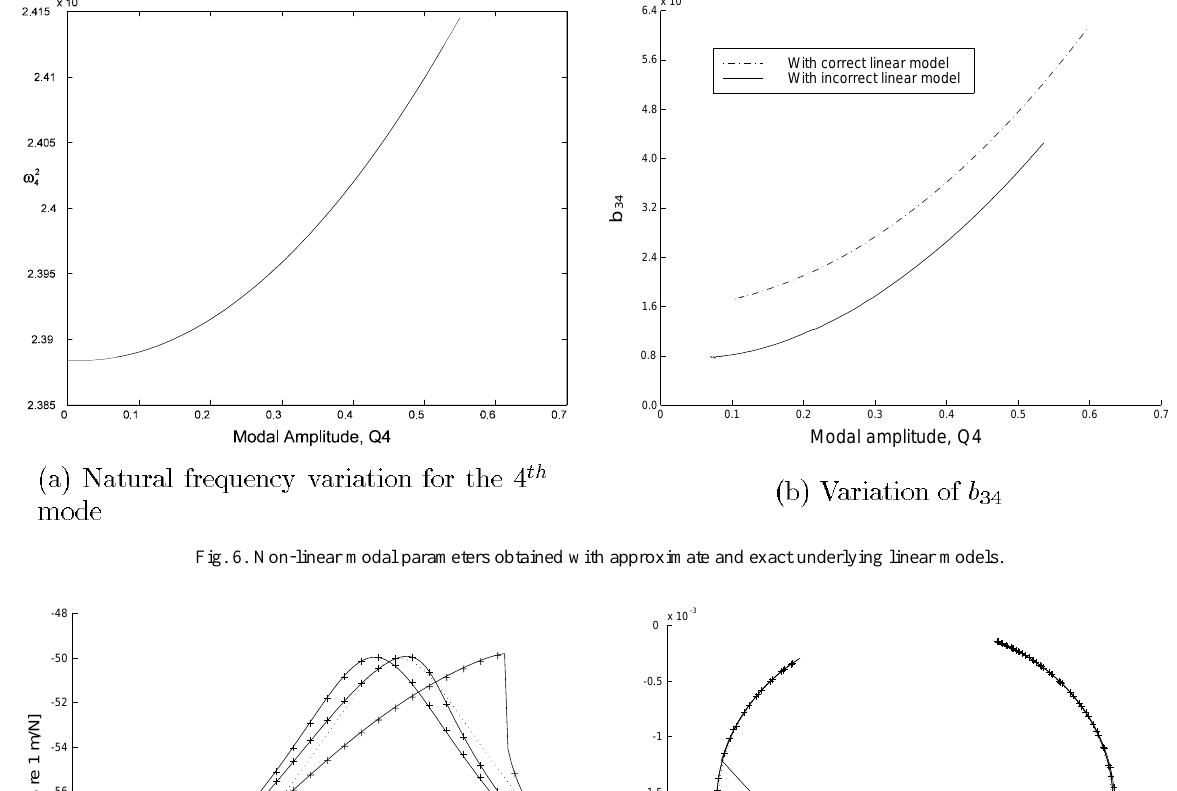
Fig. 6. Non-linear modal parameters obtained with approximate and exact underlying linear models.